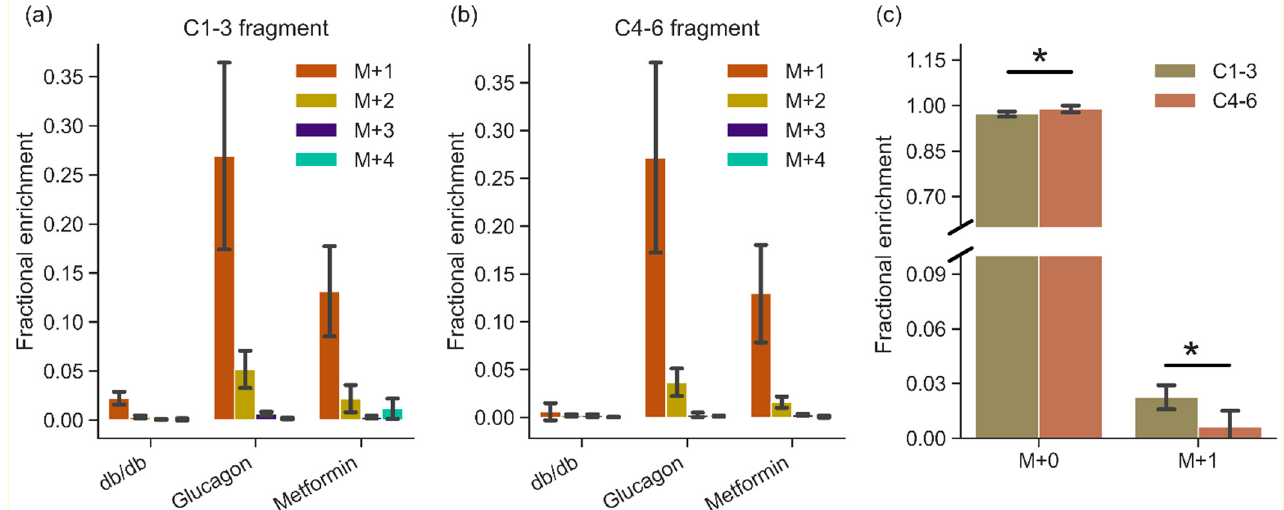
Figure 3. GC-MS analysis of glucose produced by the livers showing mass fragments containing ( a ) carbons 1–3 and ( b ) carbons 4–6 of glucose. Mass isotopomers are represented as M+0, M+1, M+2, M+3, and M+4 to indicate increasing mass of fragments. m / z values of fragments are listed in Table S3. Natural abundance mass fragment (M+0) is not shown for clarity. ( c ) Comparison of M+0 and M+1 mass isotopomers between two halves of glucose (C1–3 and C4–6) produced by db/db livers (n = 6). Mass fragments are from carbons 1–3 and 4–6 in glucose post aldonitrile-pentapropionate derivatization reaction, as detailed in the methods. Error bars are standard deviation. n = 6 ( db/db ), 5 (glucagon), and 6 (metformin). * denotes statistical significance ( p < 0.05; two tailed Student’s T -test).